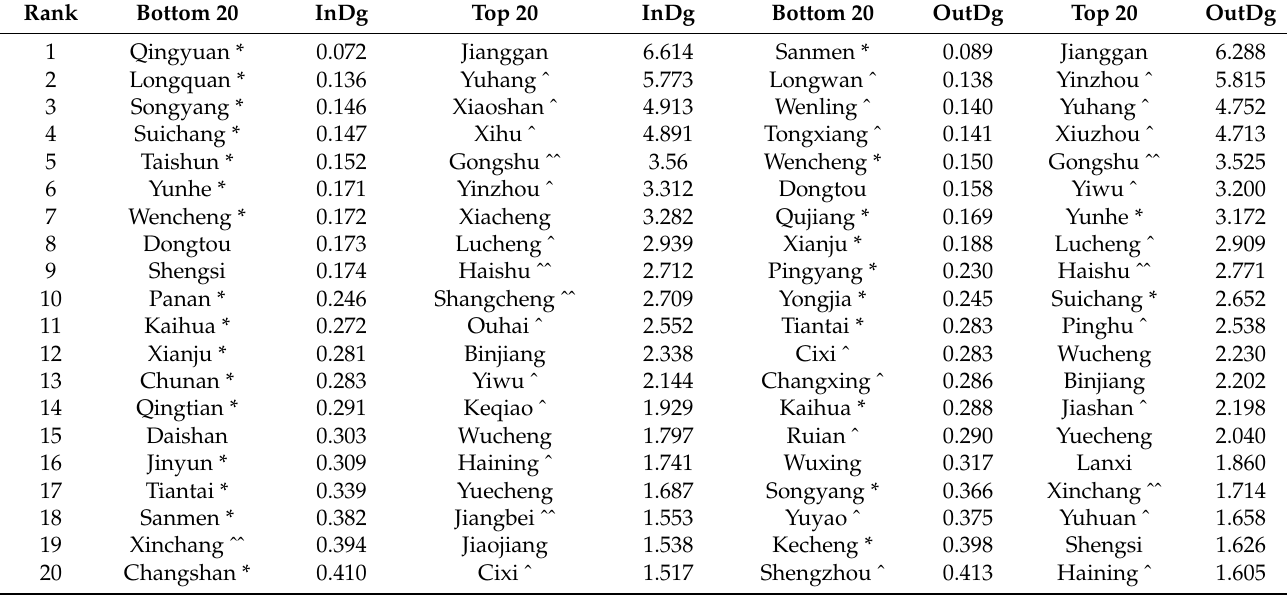
Table A1. Degree centrality of the top and bottom 20 (county-level)